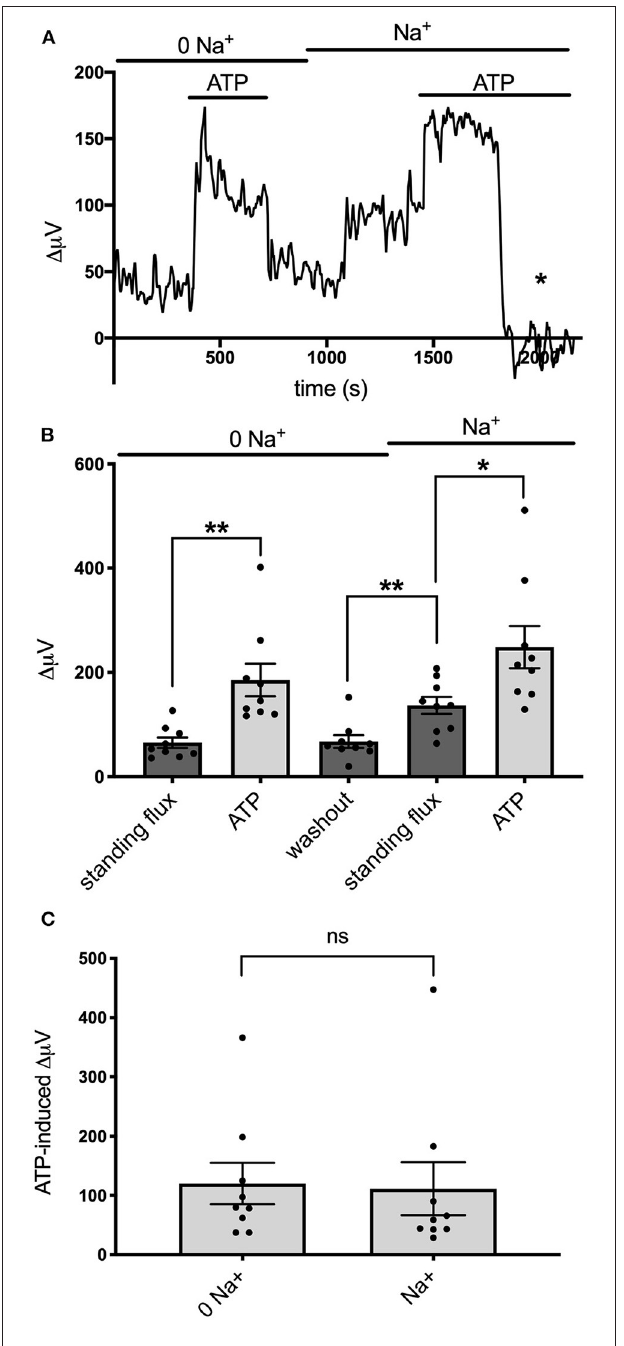
FIGURE 7 | Effects of alterations in extracellular sodium on ATP-induced increases in H + flux. (A) Trace showing H + flux signals in response to 100 µ M ATP from a single cell cultured from mouse hippocampus first when bathed in 0mM extracellular sodium and then when extracellular sodium was restored to normal levels. Restoration of sodium induced a notable increase in the standing H + flux. Asterisk indicates response of self-referencing H + -selective electrode when in a control location 600 µ m above the cell. (B) Quantitative results averaged from cultured mouse hippocampal cells showing H + flux in cells first bathed in 0mM sodium and then when normal levels of sodium were restored; N = 9. *indicates 0.01 < P < 0.05; **indicates P < 0.01. (C) Responses to ATP from the same cells when the contribution of the standing H + flux observed prior to application of ATP was subtracted out; N = 9. ns, indicates not significantly different ( P > 0.05).